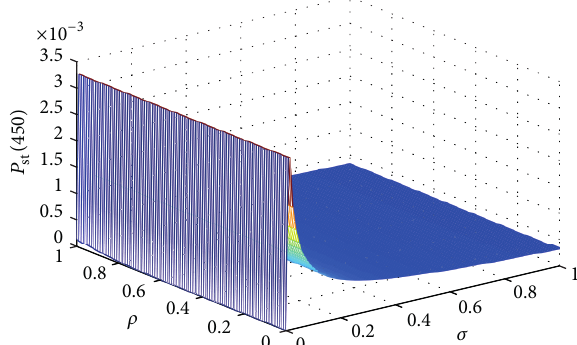
Figure 7: The three-dimensional diagram of the stationary prob- ability distribution function of credit risk contagion 𝑃 function of 𝜎 and 𝜌 when 𝑁 = 450 , 𝜏 = 4 , 𝜇 = 0.03 , 𝜉 = 3 , 𝜆 1 = 0.15 , = 0.08 , and 𝛼 = 0.4 𝜆 2